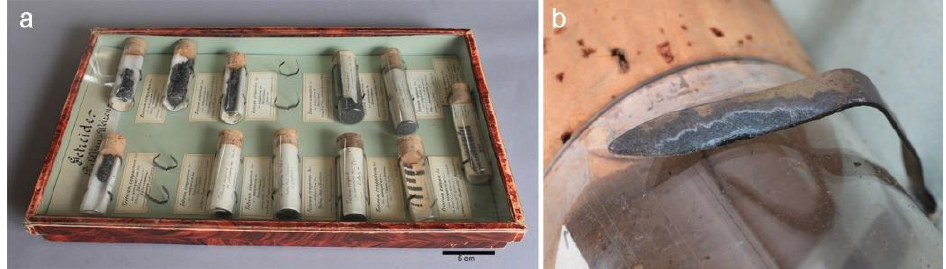
Figure 9. ( a ) Reagent tubes held by metal clamps to display plant remains in the Institute of Plant Biology Zurich; ( b ) corrosion on a metal clamp. (Photo: HE-Arc CR). Biology Zurich; ( b ) corrosion on a metal clamp. (Photo: HE-Arc